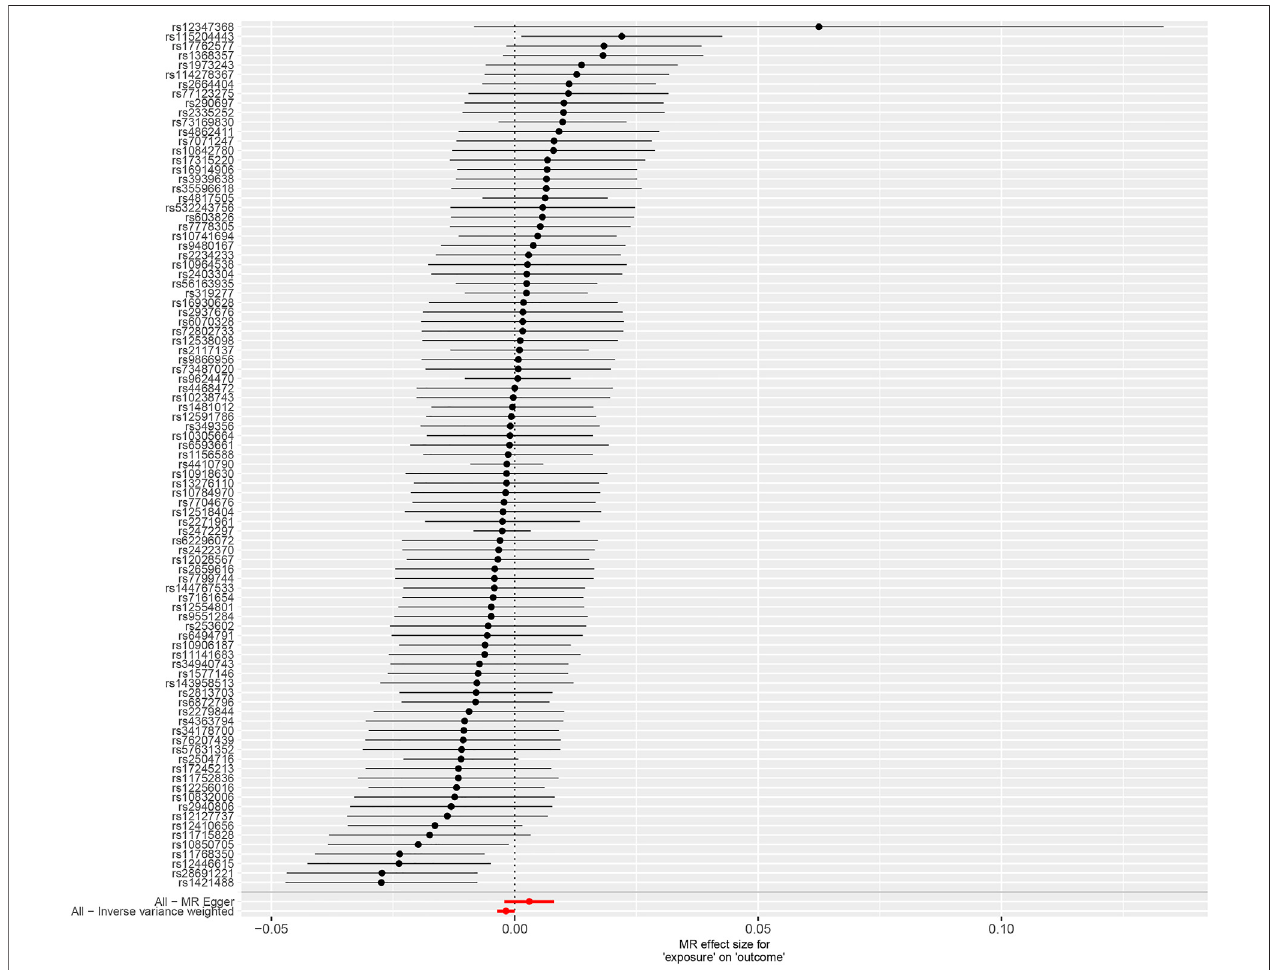
FIGURE 2 | Forest plot to show the causal effect of tea consumption on obesity. Forest plot of IVW and MR-Egger regression method. MR, Mendelian randomization.